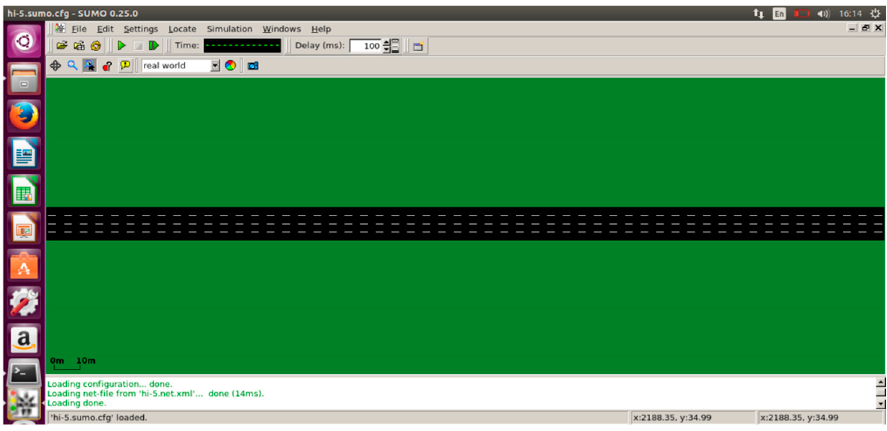
Figure 7. Highway Scenario using SUMO.